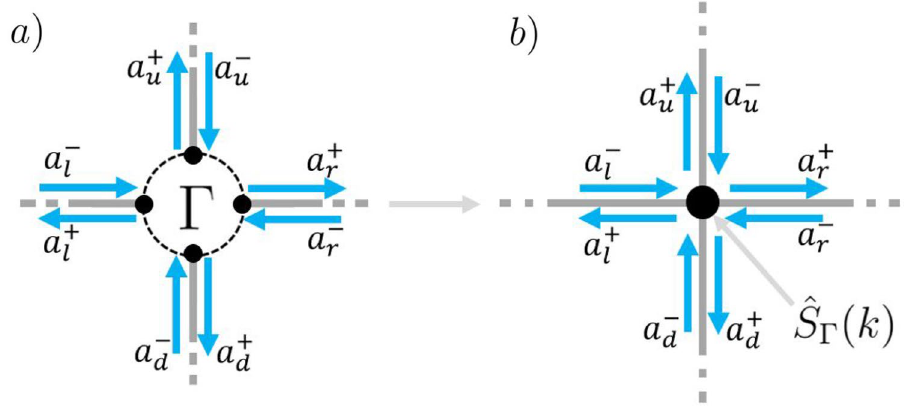
Figure 2. ( a ) Some arbitrary compact quantum graph Ŵ( V , E , L ) . ( b ) The graph having been reduced to a single vertex. Noted are the lead wave amplitudes a ± L